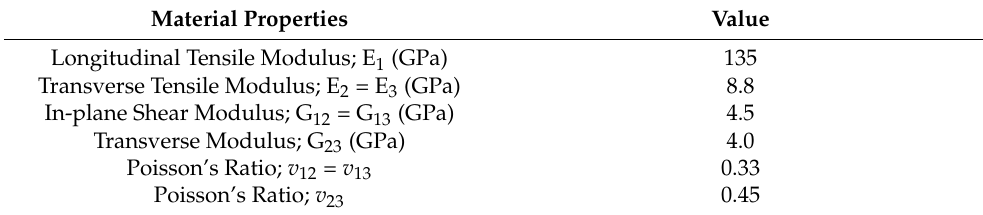
Table 2. Material Properties of T300/QY8911 CFRP Composite Lamina [38].